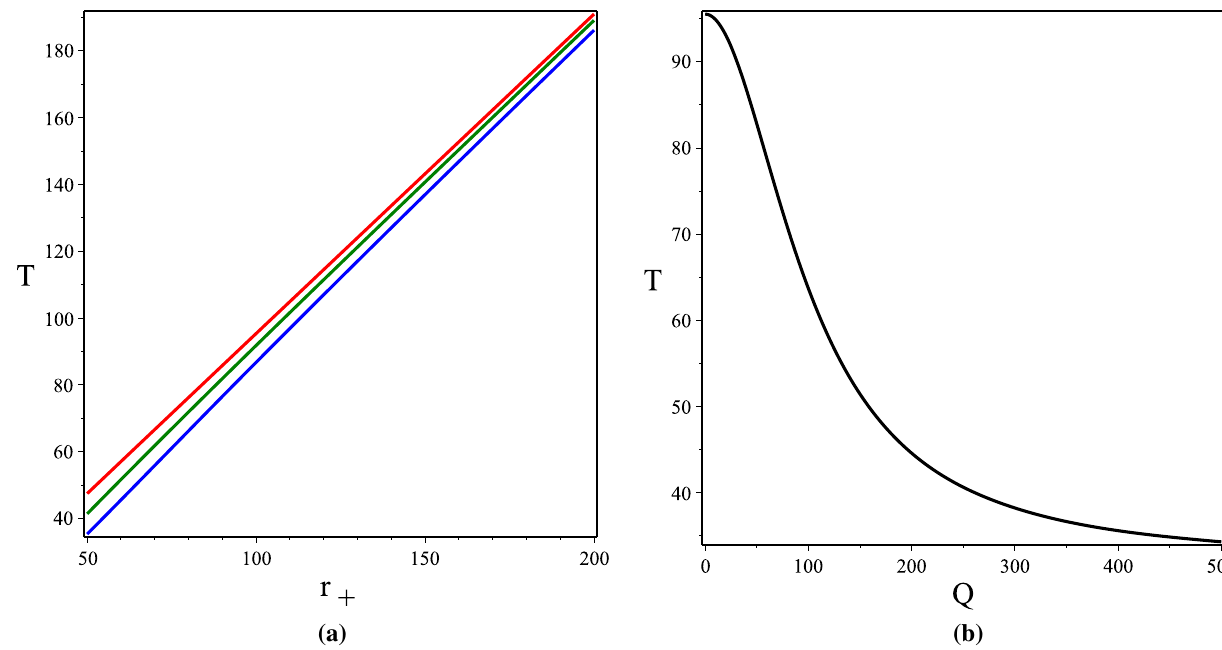
Fig. 10 The behavior of T in terms of r + for Q = 5 , 25 , 40 (left), and the behavior of T in terms of Q for b = 1 , l = 0 (right)